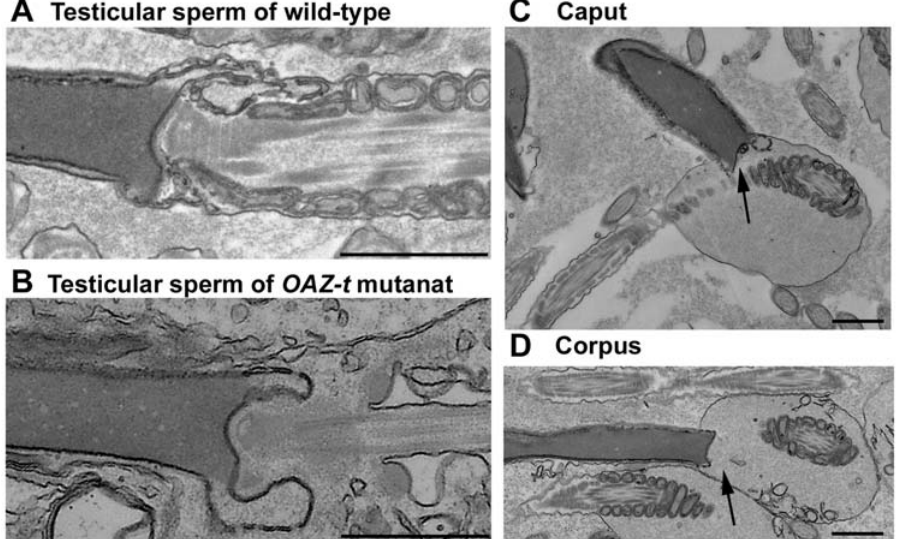
Figure 3. Electron microscopic observation of morphology for sperm maturation in testis and epididymis. The head-tail junction in testicular sperm of wild-type (A) and OAZ-t null mutant (B) is shown. The sperm tail in the homozygous OAZ-t mutant epididymis (C,D) was improperly arranged at the head tail junction. Arrows indicate the abnormal head-tail jounction. Bar=1.0 m m (A–D).